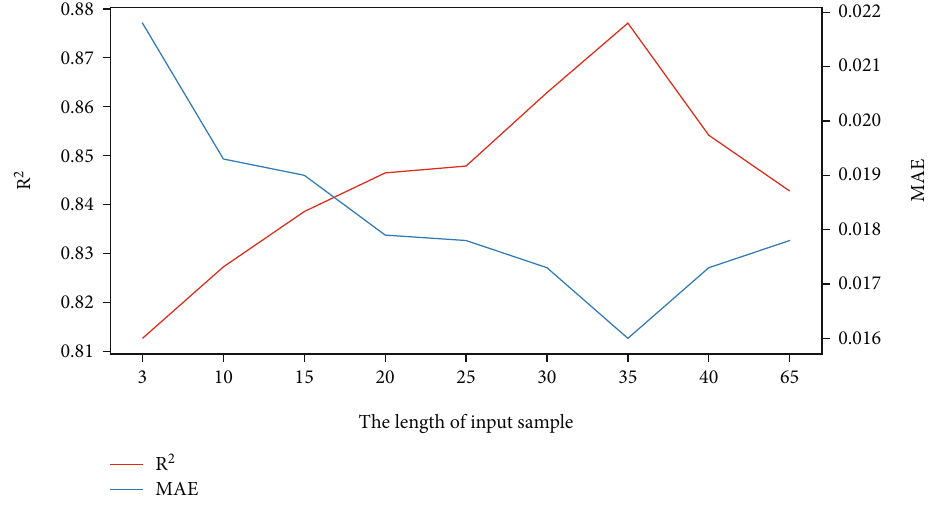
Figure 13: R 2 and MAE comparison of nine experimental results based on 2DCNN-GRU hybrid network.